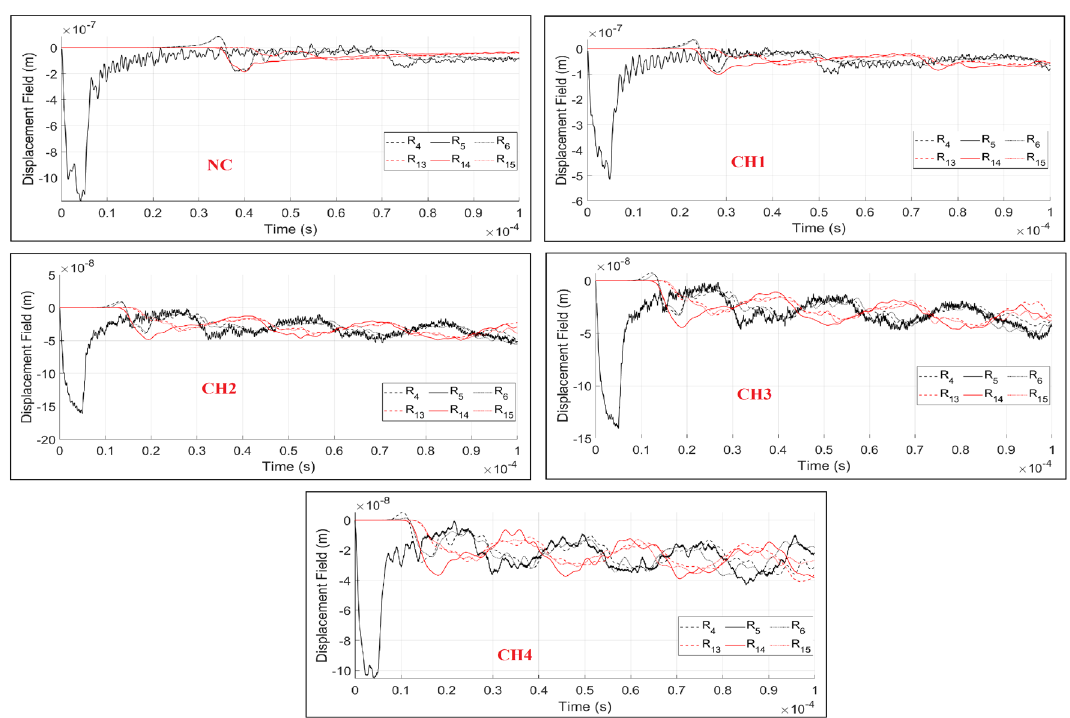
Figure 15. The recorded time histories at the receiver sensors ( R i ) under consideration of different heterogeneity ratios in concrete beam domain: NC, CH1, CH2, CH3 and